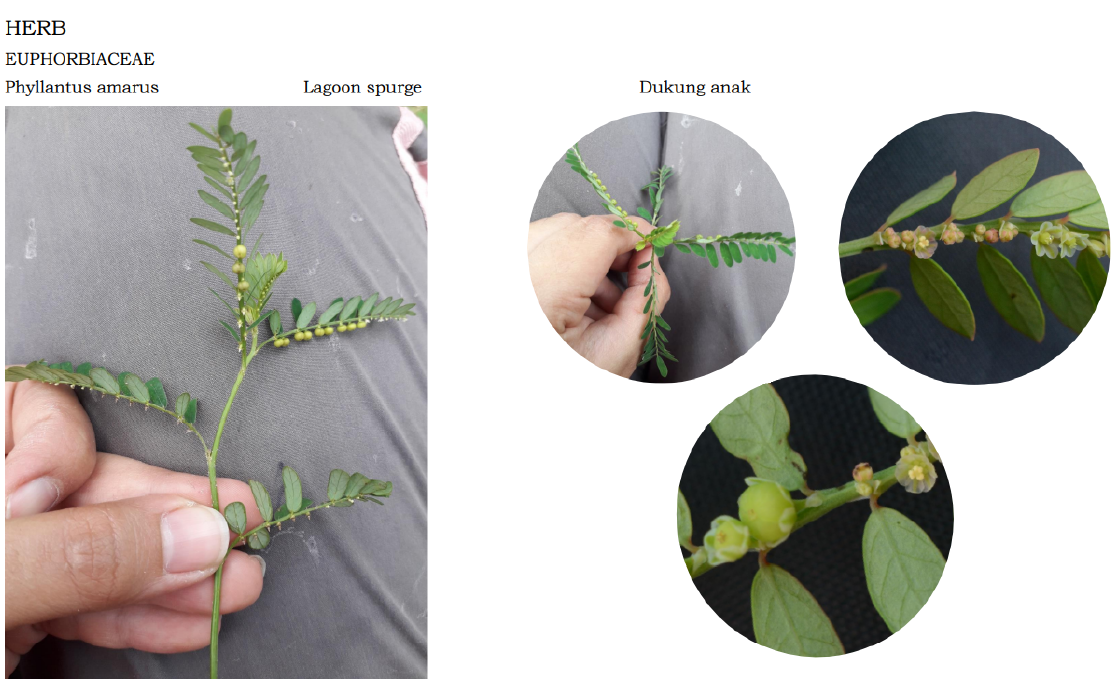
Figure A4. Grass Poaceae: Echinochloa colona.